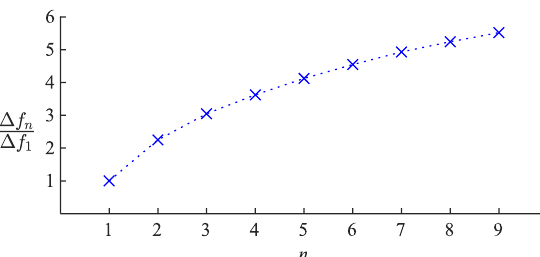
Figure 13. Sensitivity of the resonance frequency of the sinusoidal antenna sensor to the applied strain, expressed relative to the sensitivity of the traditional antenna sensor with 𝑛 = 1 , for anten- nas 𝑛 > 1 .